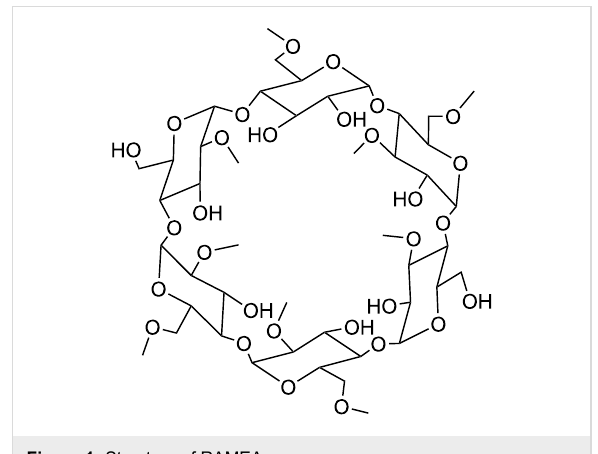
Figure 1: Structure of RAMEA.